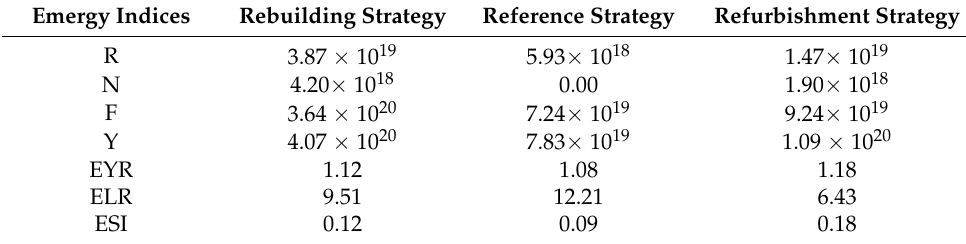
Table 9. Emergy-based